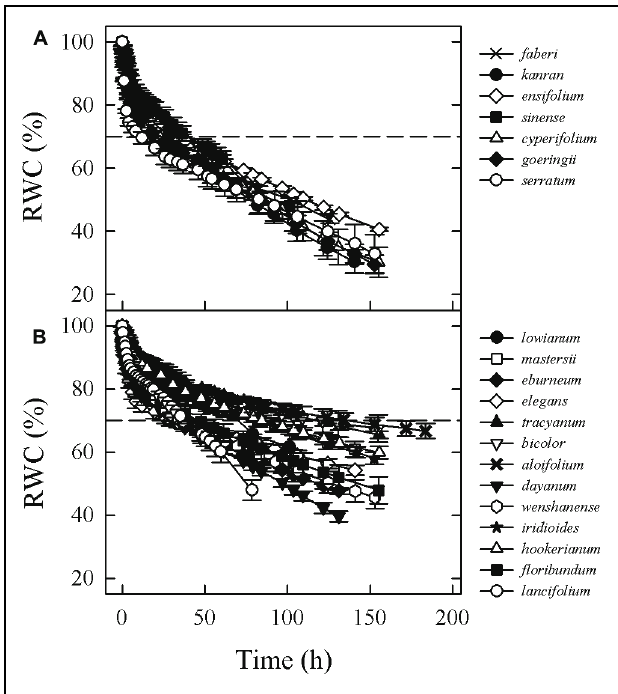
FIGURE 1 | Water loss curves for leaves from terrestrial (A) and epiphytic (B) Cymbidium species, showing changes in relative water content (RWC) with time after excision. Dashed lines indicate time required for drying of saturated leaves to 70% RWC.